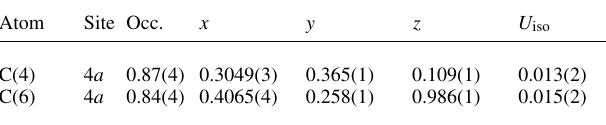
Table 2. Atomic coordinates and displacement parameters (in Å 2 )